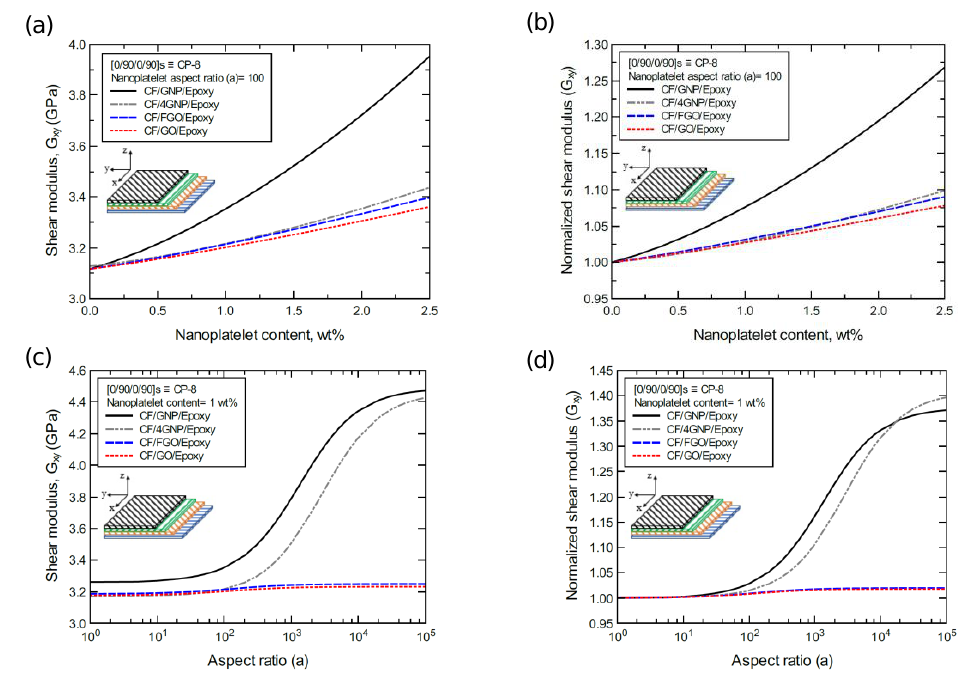
Figure 21. Comparison of the predicted in-plane shear modulus (G xy ) for a [0/90/0/90]s (CP-8)-laminated composite plate based on the nanoplatelet type, content, and aspect ratio; ( a ) predicted G xy for various nanoplatelet contents at 100 aspect ratio, and the normalized response is shown in ( b ); ( c ) predicted G xy for various aspect ratio values at 1.0 wt% nanoplatelet content, and the normalized response is shown in ( d ). The volume fraction of CF is 56%.